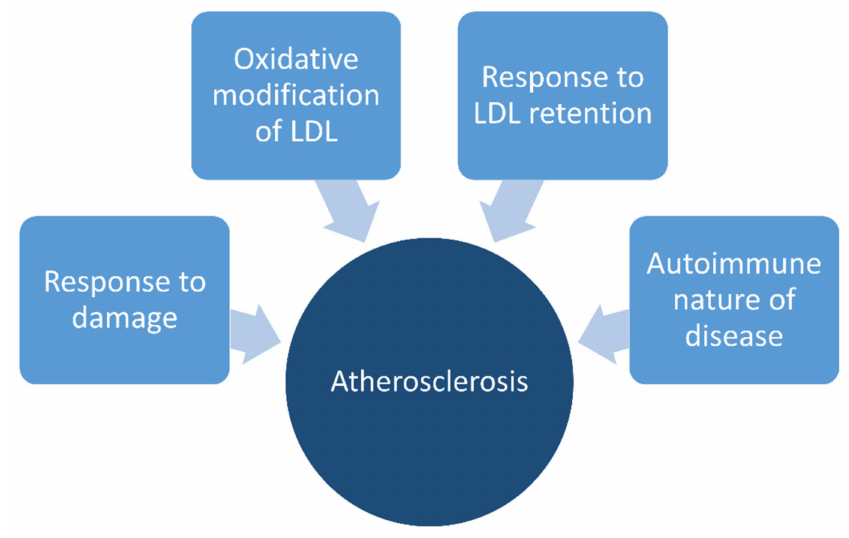
Figure 1. Hypotheses of the pathogenesis of